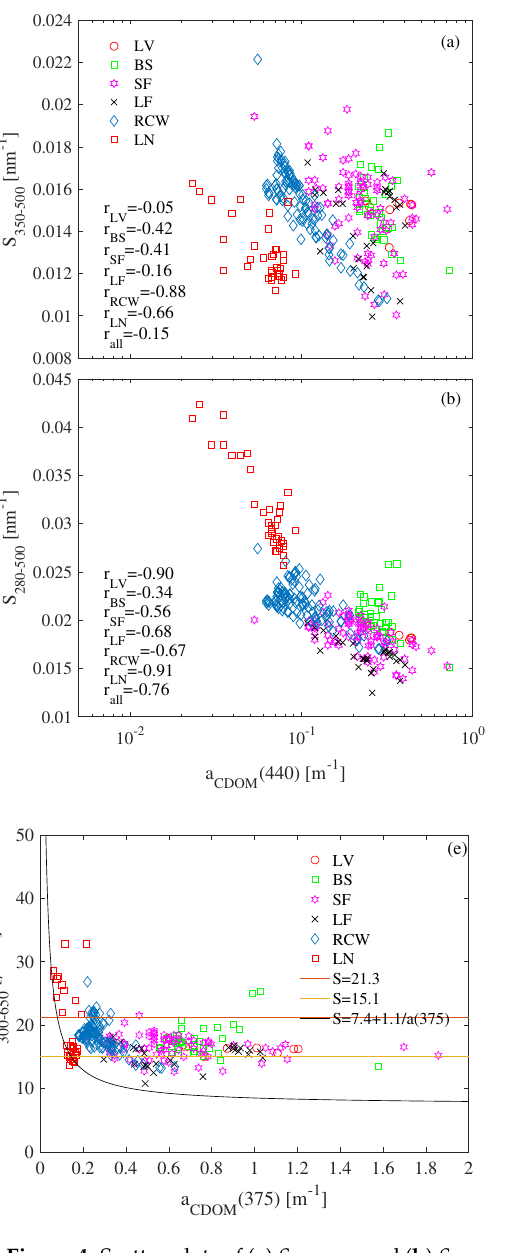
Figure 4. Scatter plots of ( a ) S 350 − 500 and ( b ) S 280 − 500 for all six study sites versus the CDOM absorption coefficient at 440 [ a CDOM ( 440 ) ]. Scatter plots of ( c ) S 350 − 500 and ( d ) S 280 − 500 for all six study sites versus the CDOM absorption coefficient at 320 [ a CDOM ( 320 ) ]. r is the correlation coefficient between S 350 − 500 or S 280 − 500 and the natural logarithm of a CDOM ( 440 ) or a CDOM ( 320 ) for each study site as specified by the subscript. r all is the correlation coefficient for all study sites. ( e ) Scatter plots of the